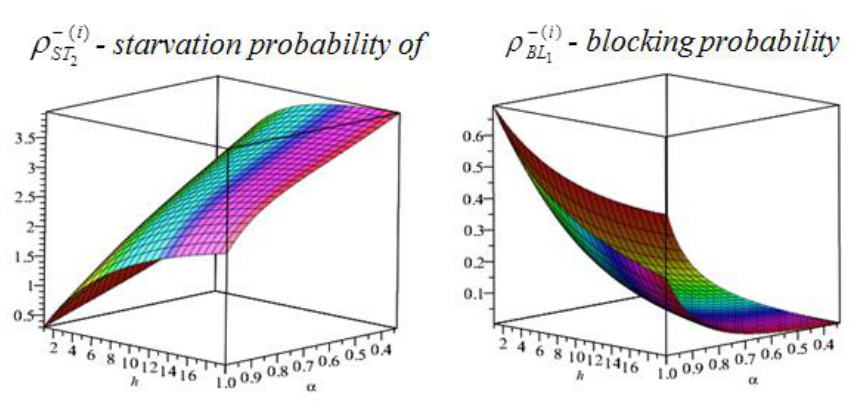
Figure 12 . The starvatiоn